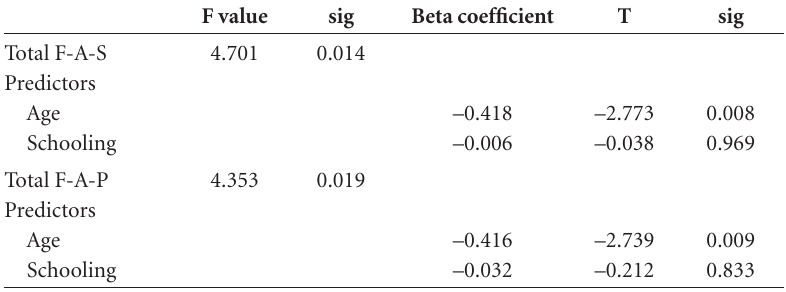
Table 3. Results of multiple linear regression